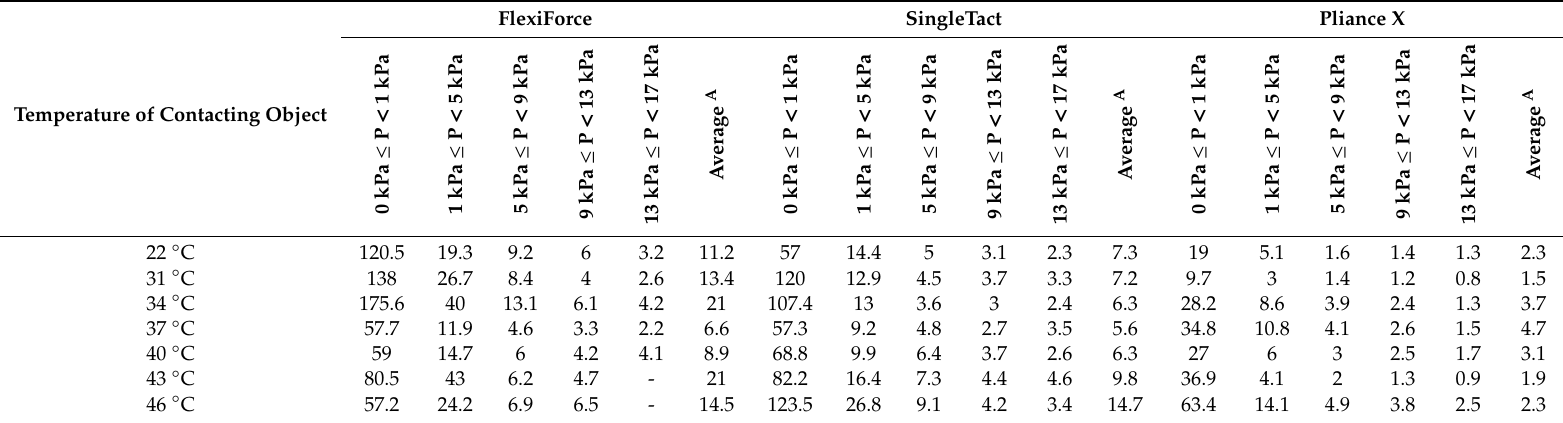
Table 4. Repeatability of di ff erent sensors measured at di ff erent contacting temperatures (Coe ffi cient of variation for repeated measurements of sensor reading).